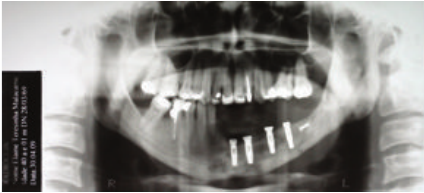
Figure 7: Panoramic radiographic showing implants placed in